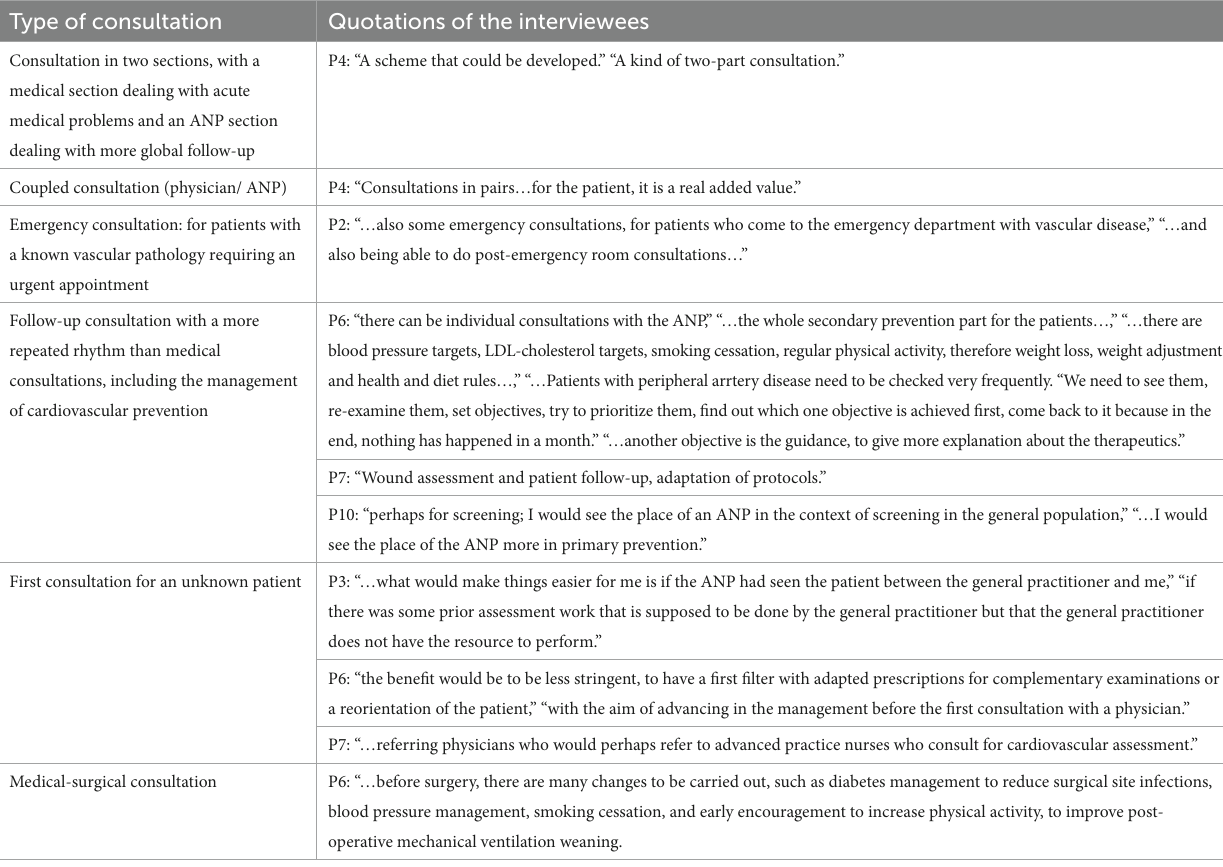
TABLE 3 Proposals of the physicians regarding the place of an Advanced Nurse Practionner (ANP) in the